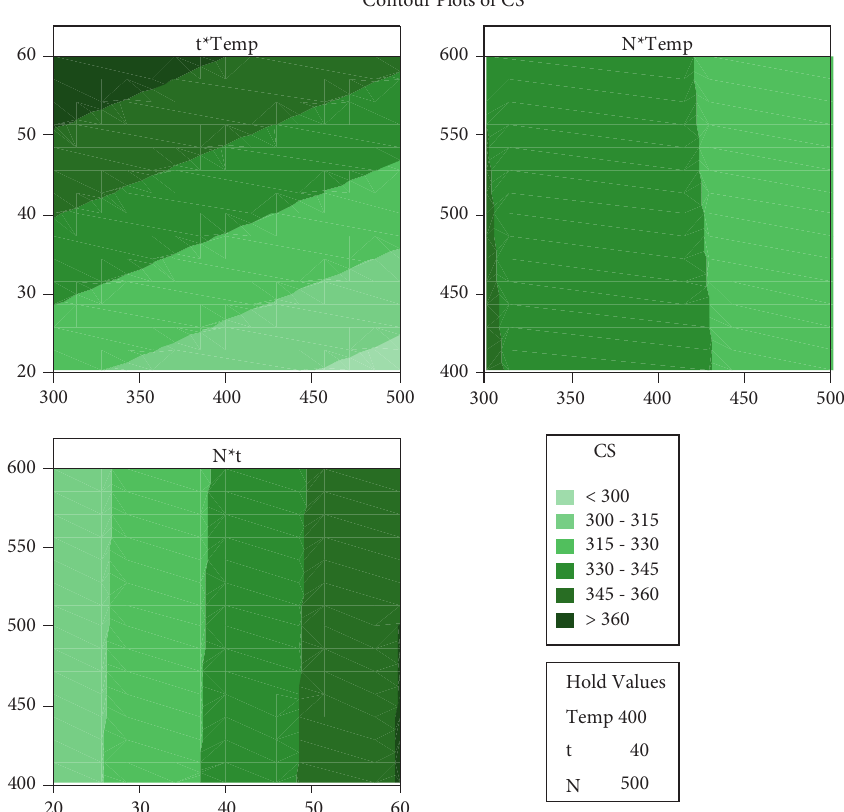
Figure 8: Comparison of the compressive strength using contour plots (temp: temperature in ° C; t : time in sec; N : stir speed in rpm).